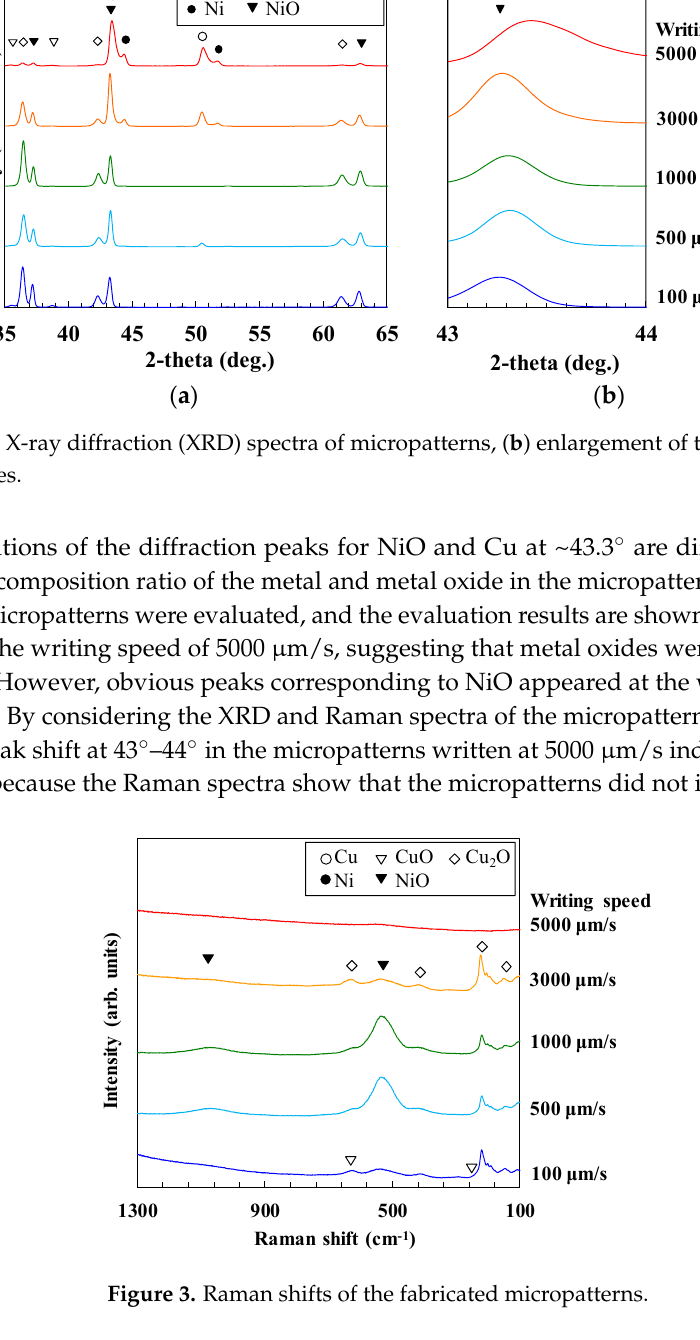
Figure 1. SEM images of micropatterns fabricated at writing speeds of ( a ) 100 µm/s, ( b ) 500 µm/s, ( c ) 1000 µm/s, ( d ) 3000 µm/s, and ( e ) 5000 µm/s, respectively.